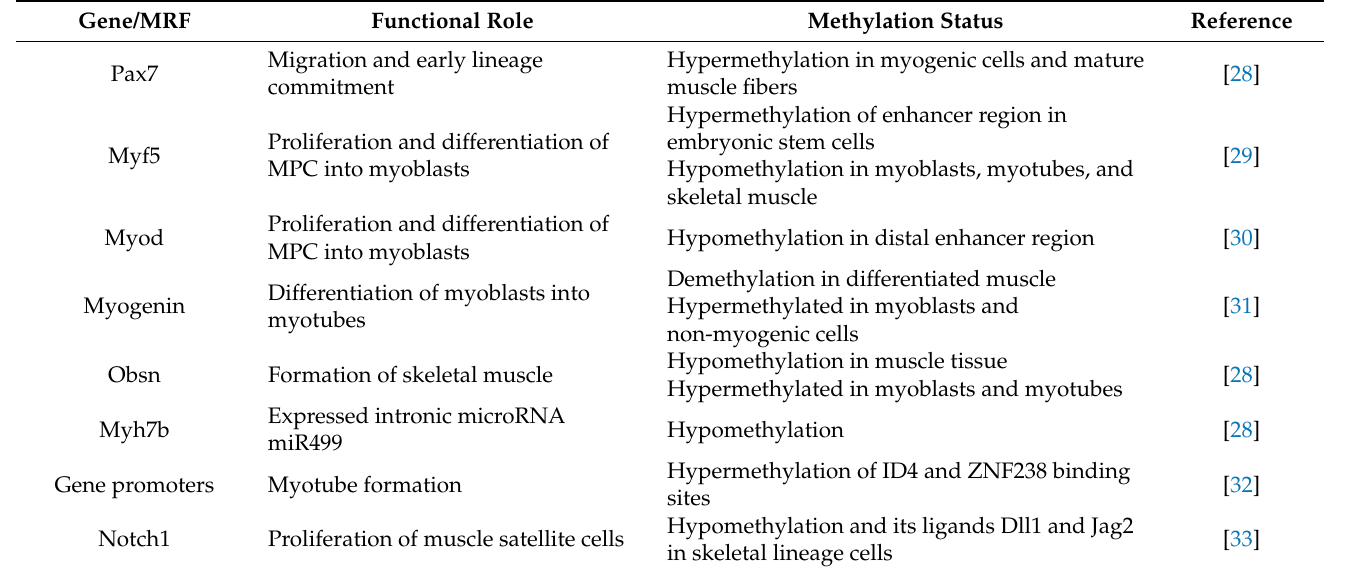
Table 1. Established roles of DNA methylation for myogenic regulatory factors (MRF).